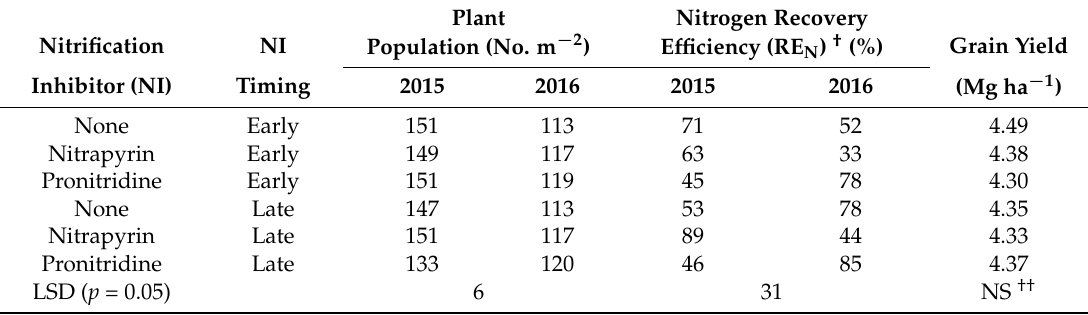
Table 4. Plant population, nitrogen recovery efficiency (RE N ), and grain yield response to nitrification inhibitor treatments averaged over UAN rates in 2015 and